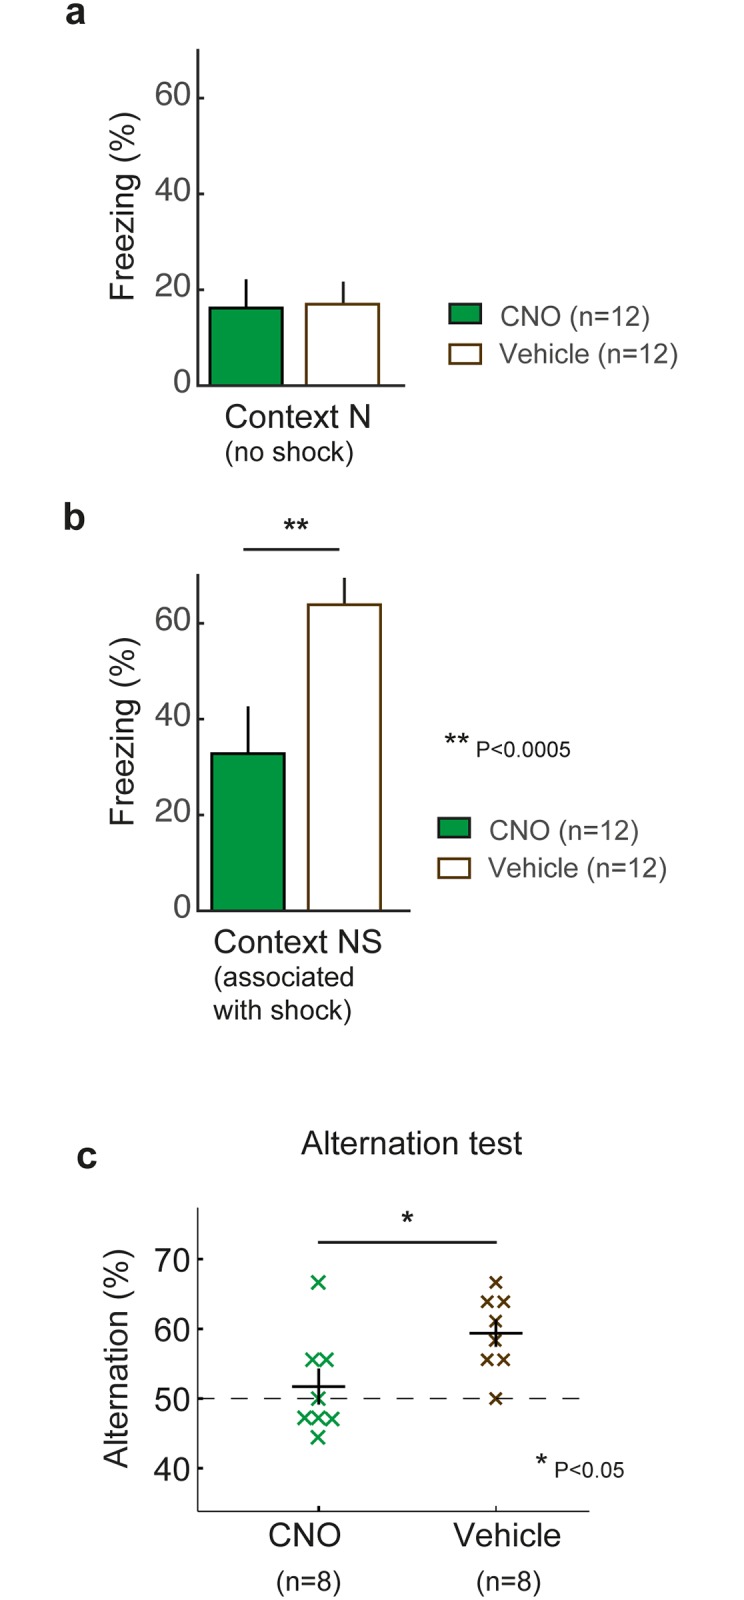
Testing the efficacy of hippocampal inactivation in hM4Di mice.a: Freezing levels in hM4Di mice following CNO and Vehicle injections in Context N ([P = 1, Signed rank test, n = 12]. No shock had been previously given in Context N. b: Freezing levels in hM4Di mice following CNO and Vehicle injections in Context NS (previously paired with a shock) [*P<0.0005, Signed rank test, n = 12]. c: Percent alternation in a T-maze spontaneous alternation task in hM4Di mice (n = 8) after CNO (green) and Vehicle (brown) injections.